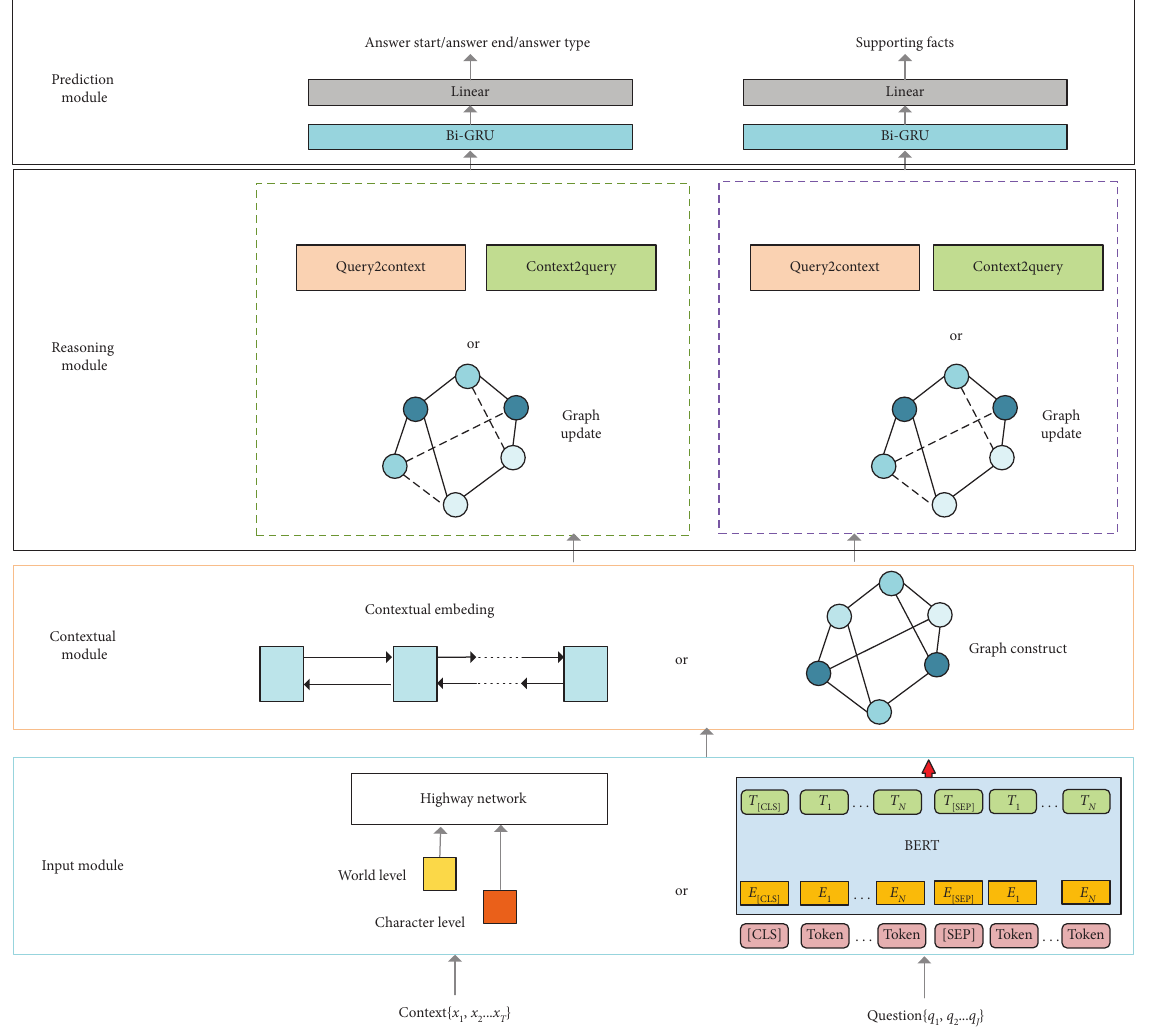
Figure 2: Overview of the dual-channel reasoning